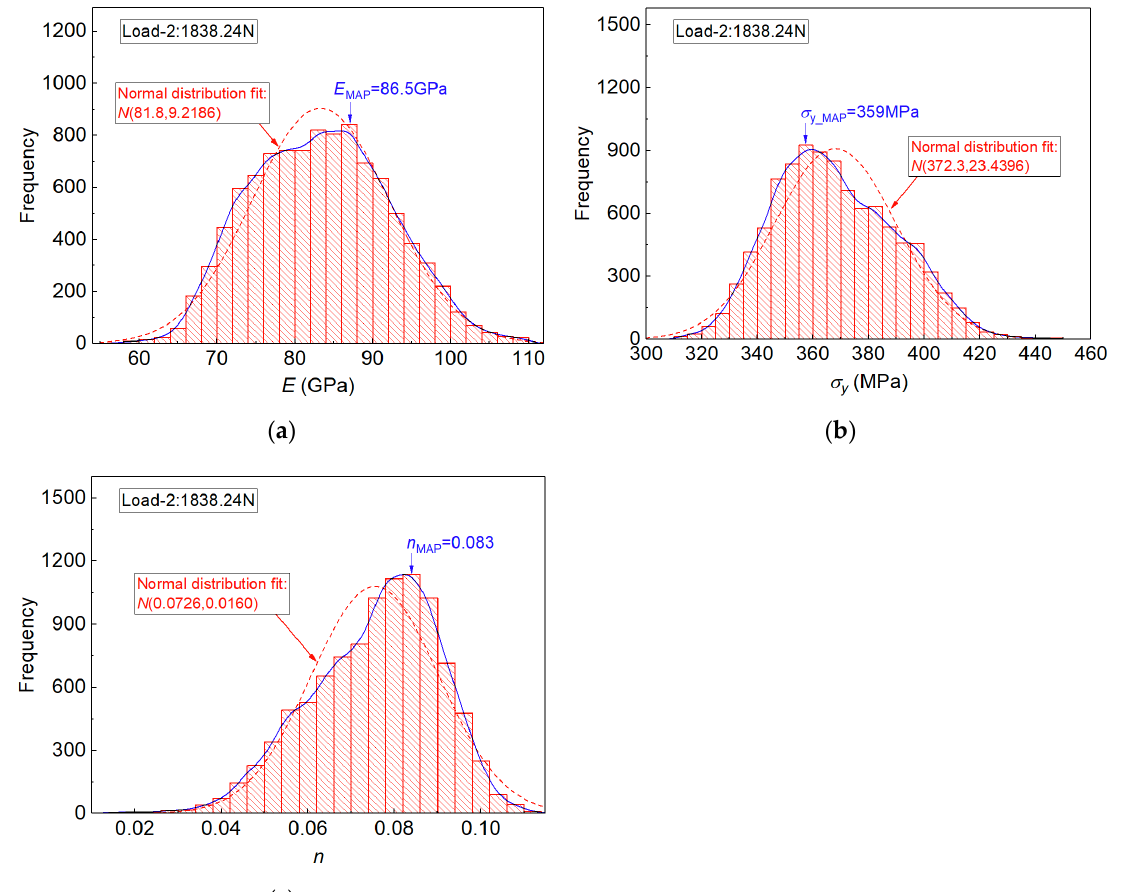
Figure 7. Posterior distribution results of the estimated elastoplastic parameters by the established measuring method and experiment imprint snapshots under indentation Load-2: in ( a ) for E , in ( b ) for σ y and in ( c ) for n Table 3. Comparison of the identified MAP, MEAN values of elastoplastic properties using the imprint snapshot under indentation Load-2.